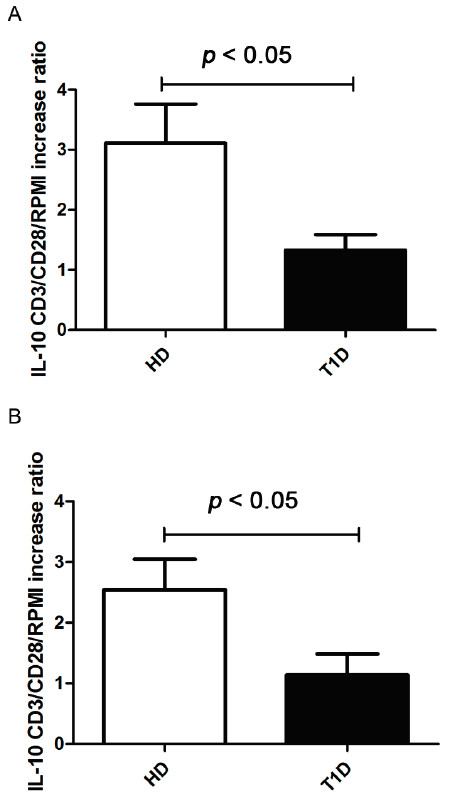
Figure 5. IL-10 secretion after four and six days of CD3/CD28 stimulation in PBMC of T1D patients compared to healthy controls. Ratio of increase of IL-10 concentrations (expressed as picograms/milliliter (pg/mL) was calculated in CD3/CD28-stimulated over unstimulated supernatants. Graphs show a significant reduction of IL-10 secretion in T1D patients compared to healthy controls, both, after four days ( A ) (Kolmogorov-Smirnov test p > 0.10; unpaired t test with Welch’s correction p = 0.0275) and six days ( B ) (Kolmogorov-Smirnov test p < 0.05; Mann Whitney test p = 0.0147) of CD3/CD28